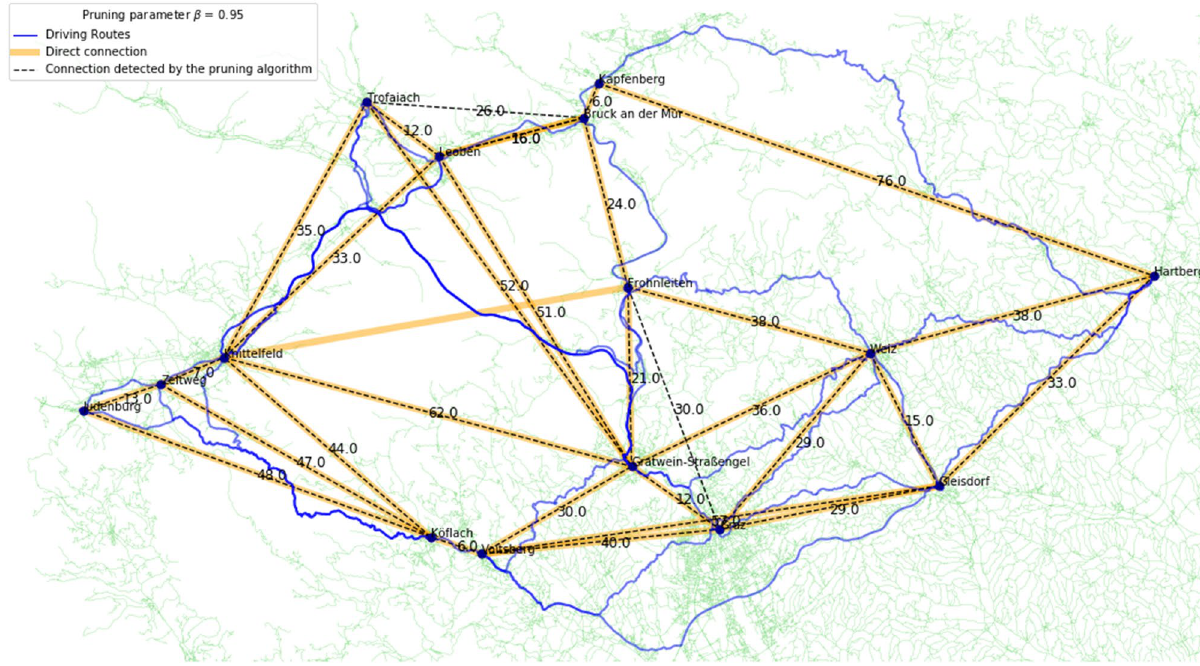
Figure 2. Connections of 15 locations in the federal state of Styria, Austria with β = 0.95